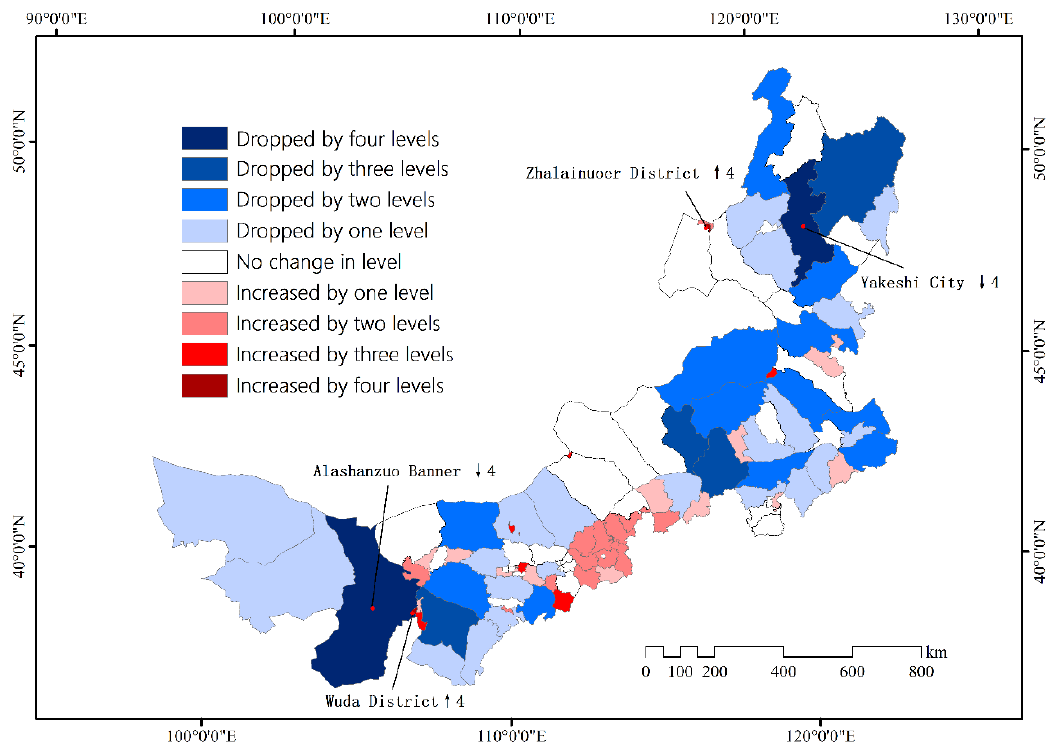
Figure 10. Differences between the Beautiful Inner Mongolia construction evaluation results based on POI quantity and POI quantity per area.